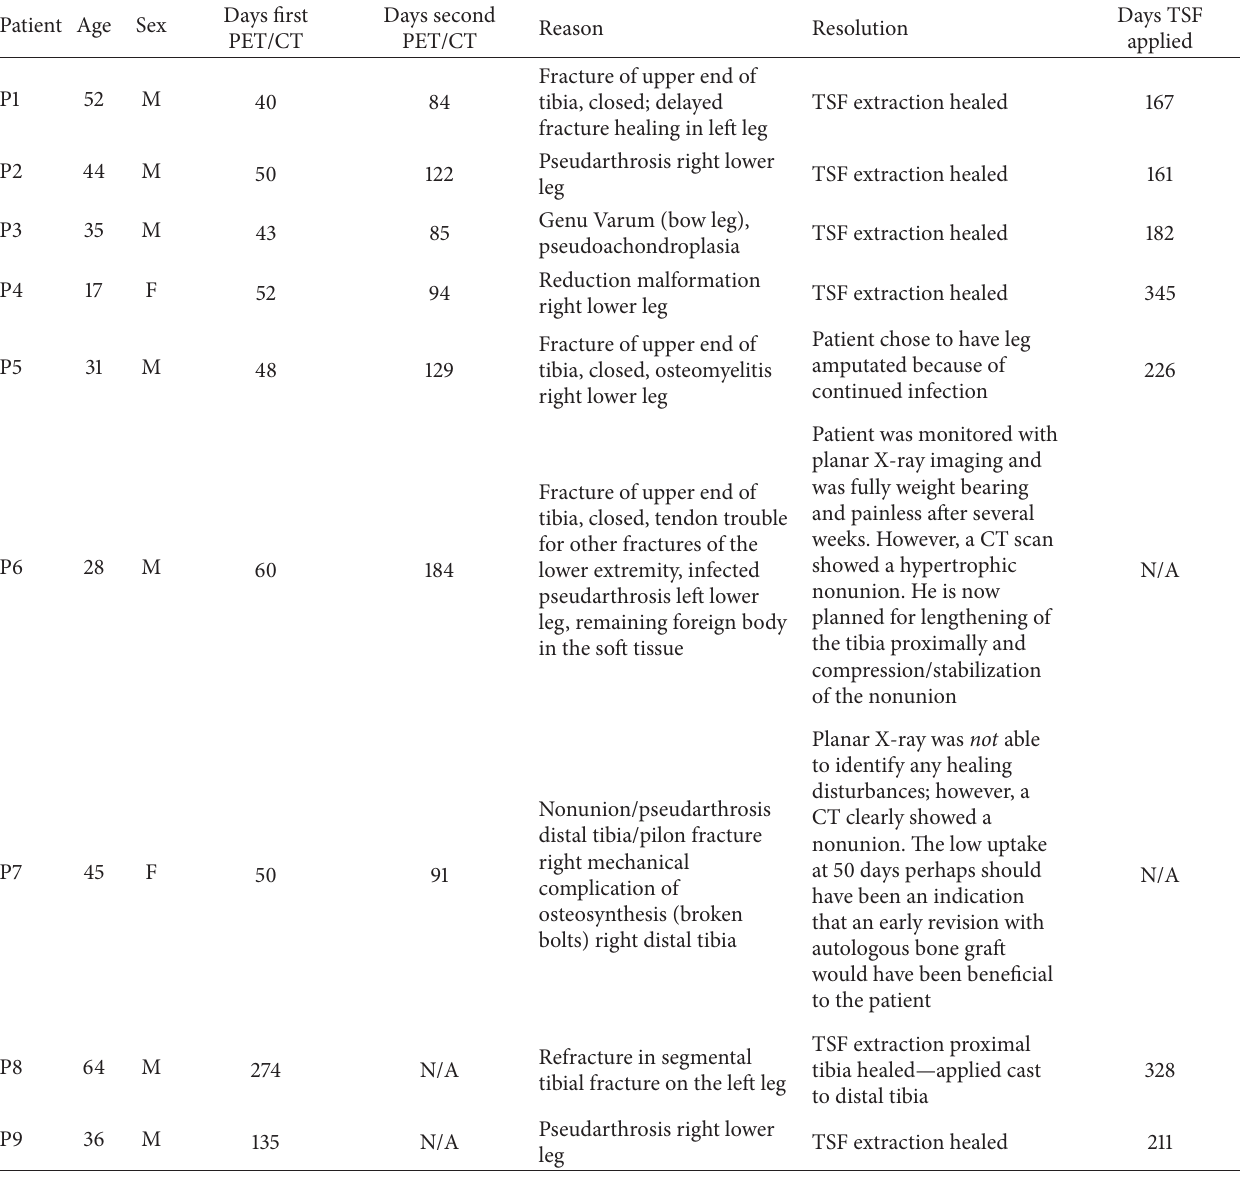
Table 1: Patient description (N/A means not applicable).